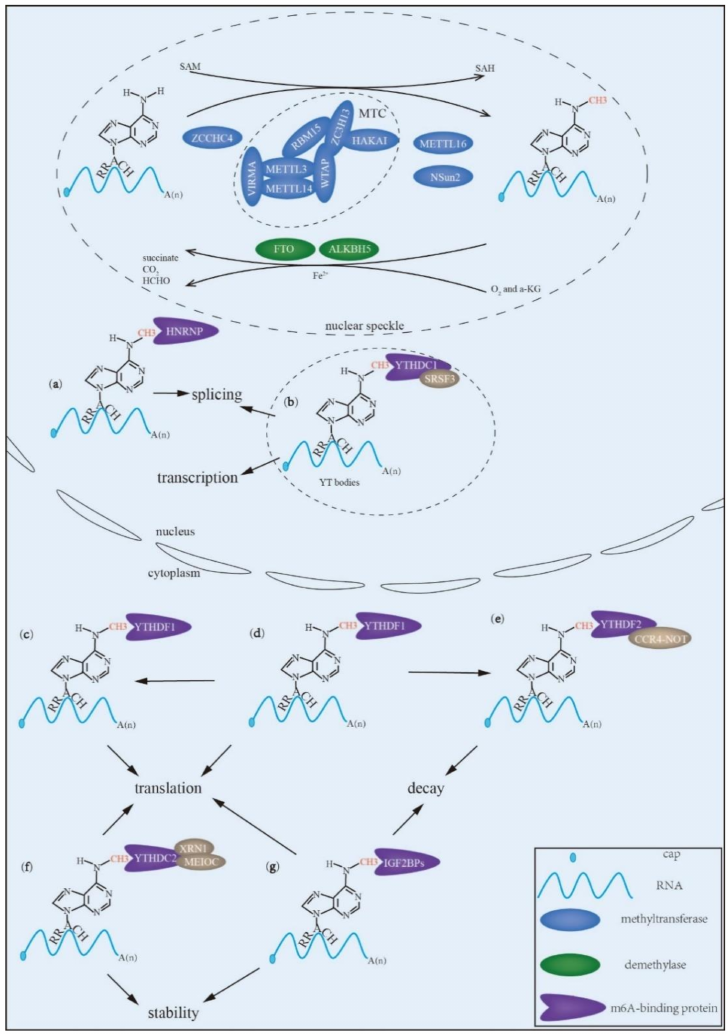
Figure 1. The regulation of RNA N6-methyladenosine (m 6 A) modification. The m 6 A modification of RNA is catalyzed by m 6 A methyltransferases including methyltransferase-like protein 3 (METTL3), METTL14, Wilms tumor 1-associated protein (WTAP), vir-like m 6 A methyltransferase associated (VIRMA), RNA-binding motif protein 15 (RBM15), zinc finger CCCH domain-containing protein 13 (ZC3H13), Cbl photo oncogene like 1 (CBLL-1, also termed HAKAI), NOP2/Sun domain family member 2 (NSun2) and CCHC zinc-finger-containing protein (ZCCHC4), and is removed by demethy- lases including fat mass and obesity-associated protein (FTO) and alkB homolog 5 (AlKBH5). In addition, the m 6 A modification is recognized and bound by m 6 A-binding proteins, which determine the fate of target RNAs—( a ) Heterogeneous nuclear ribonucleoprotein (HNRNP) particles facilitate alternative splicing. ( b ) YT521-B homology domain-containing (YTHDC) 1 participates in alternative splicing, transcription and nuclear export. ( c ) YT521-B homology domain family (YTHDF) 1 enhances translation. ( d ) YTHDF3 regulates translation. YTHDF3 synergizes with YTHDF1 to modulate trans- lation and cooperates with YTHDF2 to regulate decay. ( e ) YTHDF2 accelerates decay. ( f ) YTHDC2 participates in translation and increases stability. ( g ) Insulin-like growth factor 2 mRNA-binding proteins (IGF2BPs) augment translation, stability and